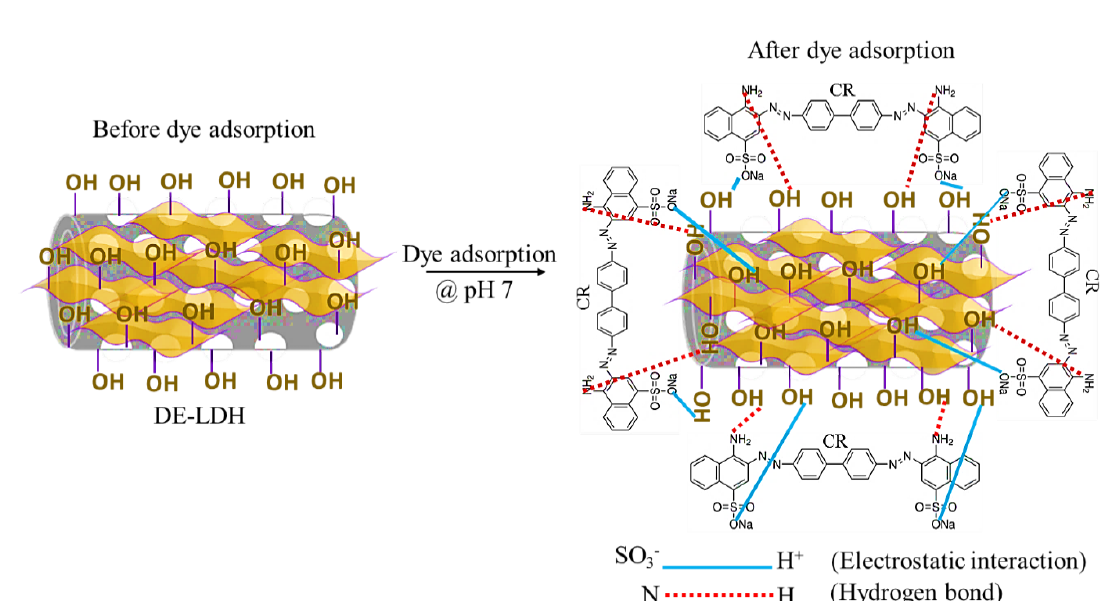
Figure 9. Schematic representation of CR adsorption mechanism onto DE-LDH.